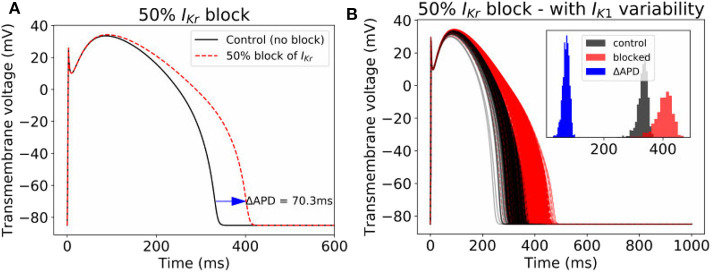
Impact of parameter variability on predictions of APD prolongation under 50% block of IKr. (A) APD prolongation under 50% IKr block, with no parameter variability. (B) corresponding action potentials (1,000 samples) when IK1 variability is included, with histograms of the control APs, blocked APs, and ΔAPD in inset.